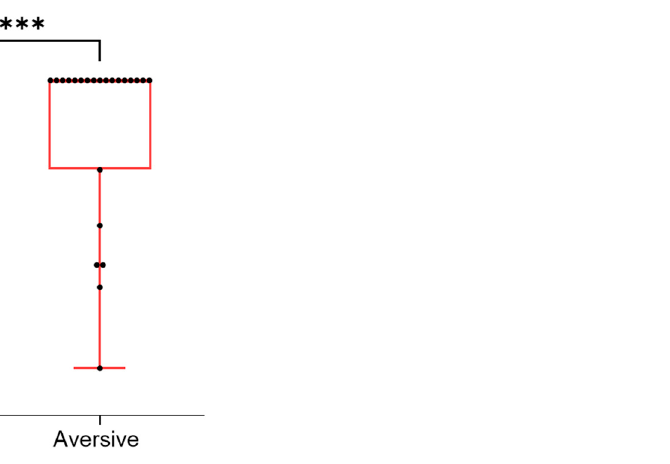
Figure 8. Latency to approach (s) positive and aversive stimulus at week ten of training in pigs ( n = 23). Data are medians with range. Significant difference is indicated with presence of asterisk ( p < 0.05).